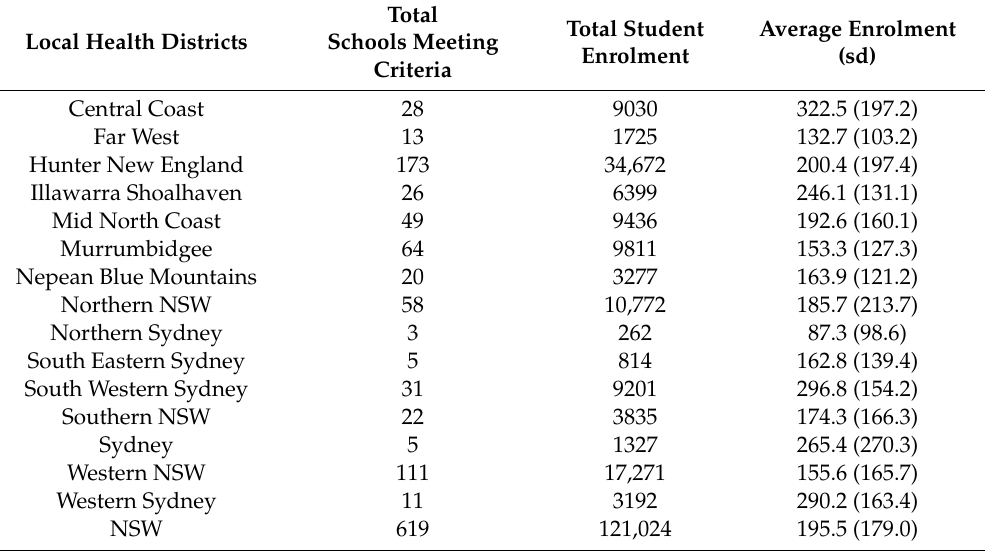
Table 2. All New South Wales primary schools where ICSEA is less than 1050 and / or Aboriginal enrolments are 12% or more, by Local Health District, 2017 2